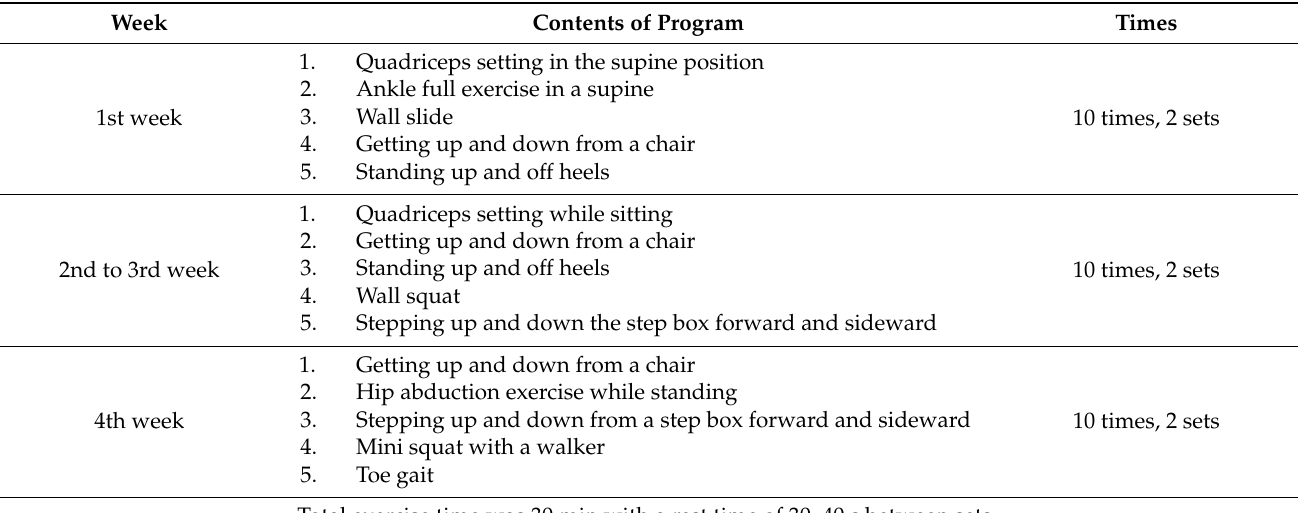
Table 1. Combined kinetic chain exercise